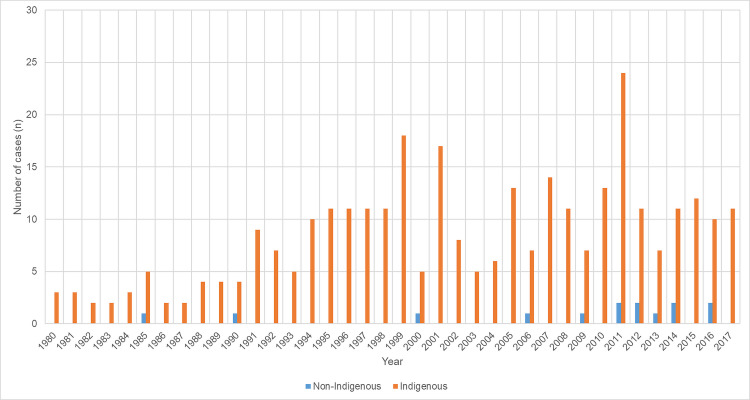
Number of new cases of ARF diagnosed in the cohort annually after 1980, stratified by Indigenous status.